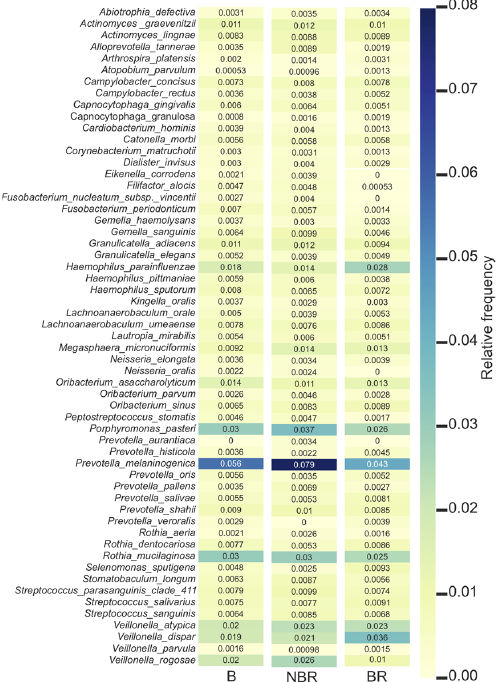
Figure 7. Species heatmap during the experimental periods.